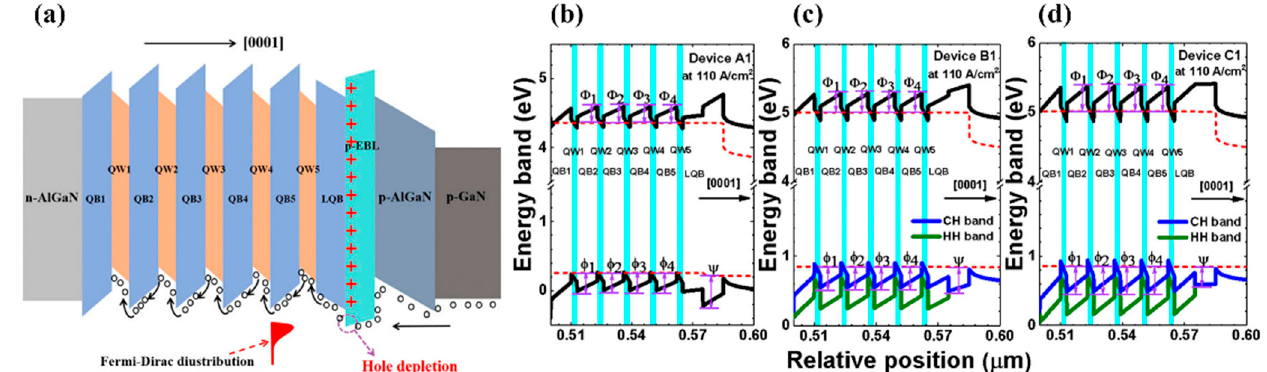
Figure 3. ( a ) Schematic energy band diagram for investigated DUV LED structures which were grown along the [0001] orientation. Polarization-induced positive charges were generated at the LQB/p-EBL interface. Energy band diagrams in the vicinity of the active region, the p-EBL and the partial p-AlGaN layer for ( b ) device A1, ( c ) device B1 and ( d ) device C1 at an injection current density of 110 A/cm 2 . Reproduced from Ref. [50] with permission from AIP